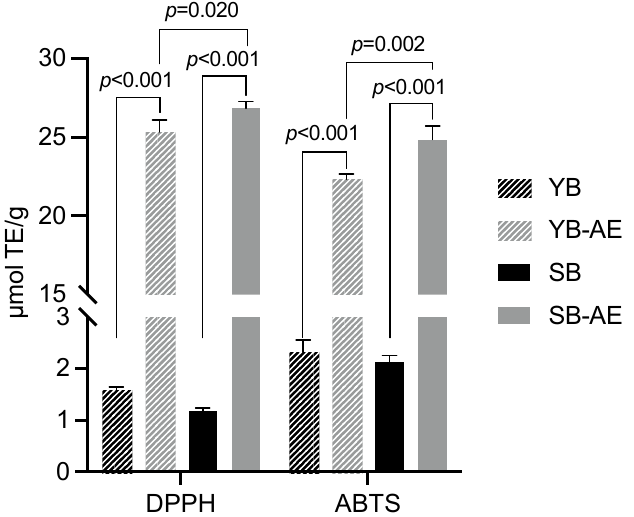
Figure 2. Radical scavenging activity, based on DPPH and ABTS assays, of bread samples. Results are expressed as µmol of Trolox equivalent (TE)/g. Bread samples were prepared with or without type-II sourdough (Y and S, respectively) and with or without a powdered artichoke extract (AE). Error bars are shown. Signi fi cant di ff erences ( p -value < 0.05) are shown as exact p -values.